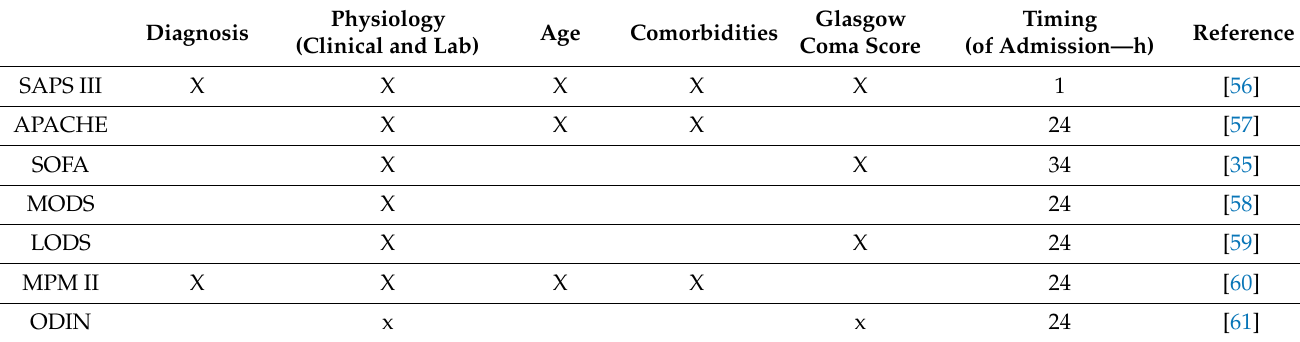
Table 2. Components of Prognostic Scores.